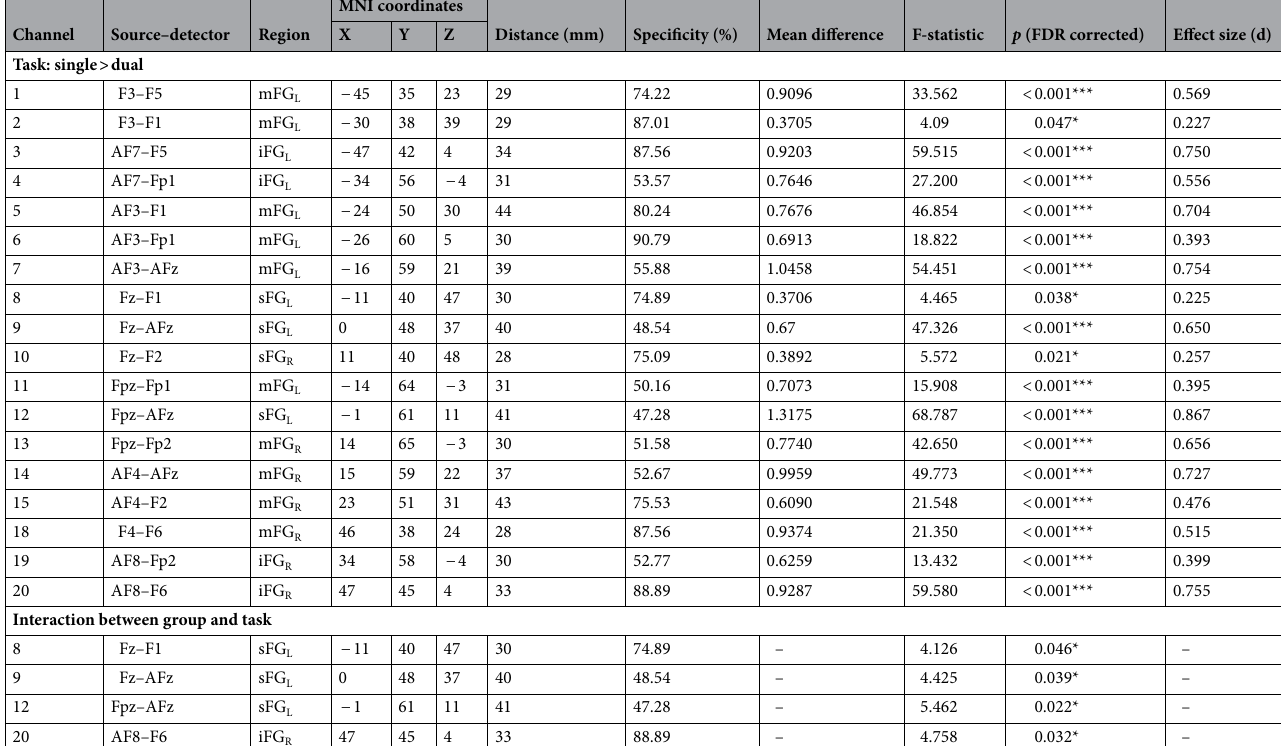
Table 1. Neural efficiency of cognitive performance (main effects). Significant Channels (at Source–Detector locations) using MNI coordinates (X, Y, and Z), with the region designation of main effects for Neural Efficiency of Cognitive Performance for Group, Task, and Interaction. Specificity/Coverage of the region per channel is detailed, with the mean difference for the comparison (not applicable in interaction between Group and Task), along with statistical information (F-statistic, p -value, and effect size [not applicable for Interaction between Group and Task]). ( p < 0.05*, p < 0.01**, p < 0.001***).